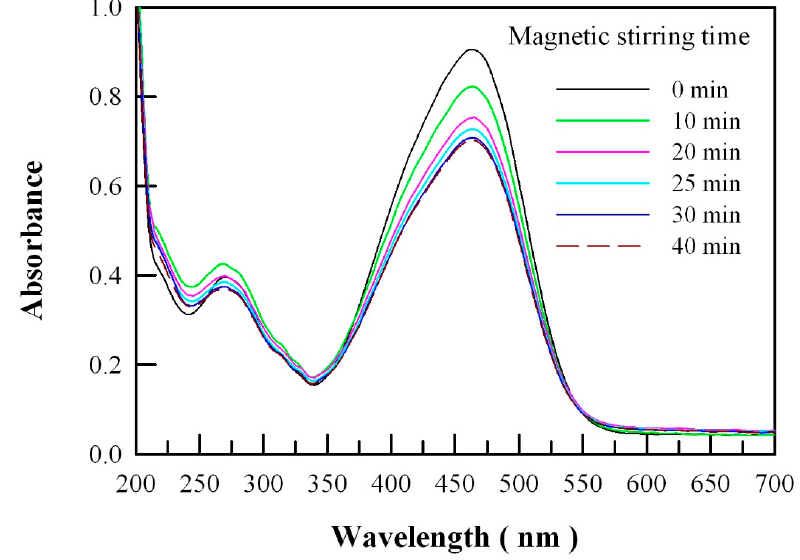
Figure 5. UV-Vis absorption spectra of aqueous methyl orange solutions after magnetic stirring with ZnO nanocrystals for different times in the dark. ZnO nanocrystals for di ff erent times in the